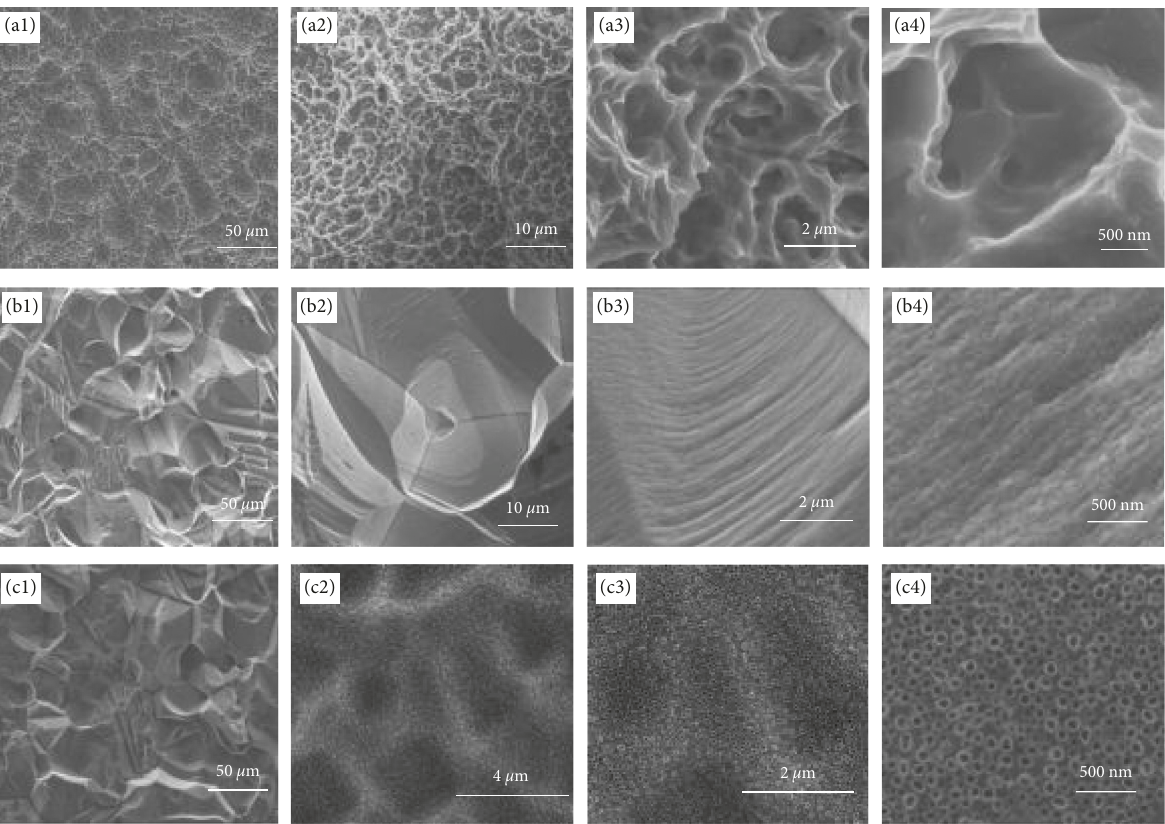
Figure 1: Surface morphologies of SLA (a), E (b), and EA (c)